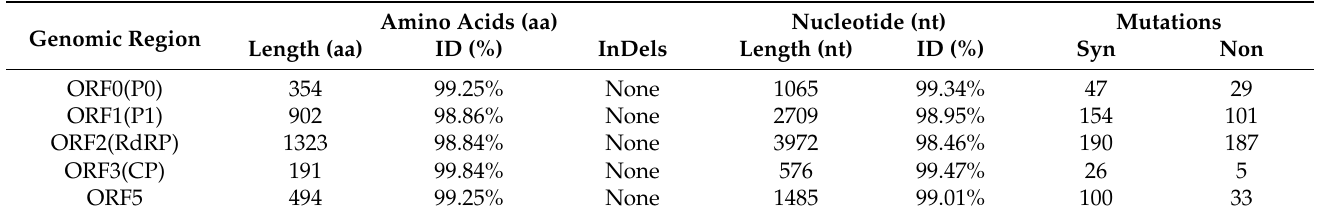
Figure 3. Phylogenetic analysis of all known CVEV isolates. ( A ) The SDT interface: color-coded pairwise identity matrix generated from CVEV sequences. Each colored cell represents a score of percentage identity between two sequences (one indicated horizontally to the left and the other indicated vertically at the bottom). ( B ) Phylogenetic trees derived from the CVEV whole genome nucleotide sequences using the maximum likelihood method. Grapevine enamovirus 1 served as the outgroup. Table 1. Sequence identities (ID) and mutations in individual proteins or genes encoded by the 23 CVEV